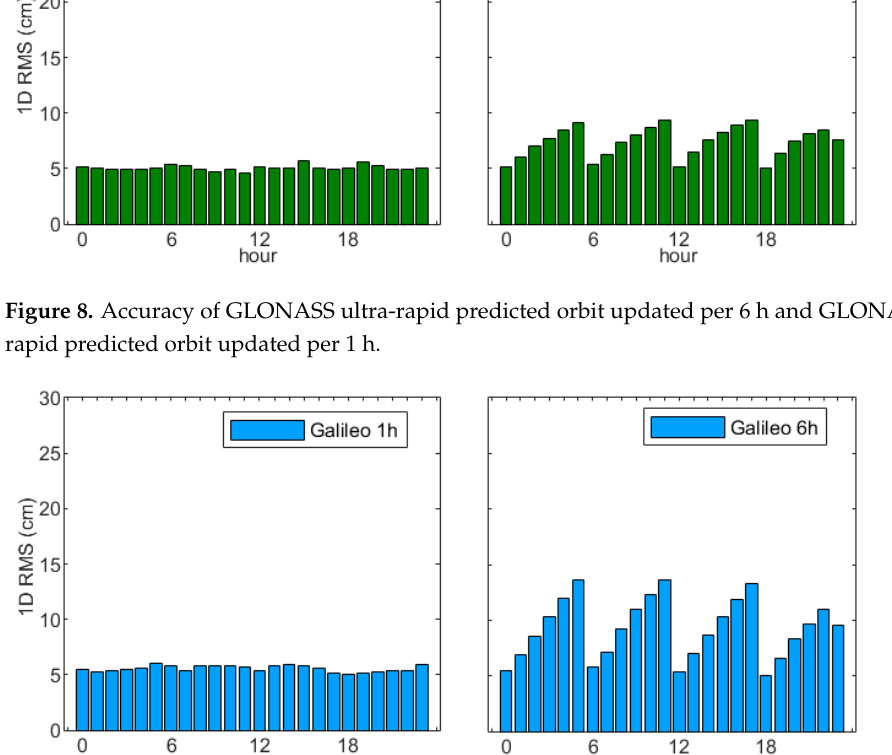
Figure 10. Accuracy of BDS ultra-rapid predicted orbit updated per 6 h and BDS ultra-rapid pre- dicted orbit updated per 1 h. From Figures 7–10, it can be seen that the accuracy of the predicted orbit of the 6-h update frequency fluctuates at different extrapolation times. The accuracies of orbit at 0